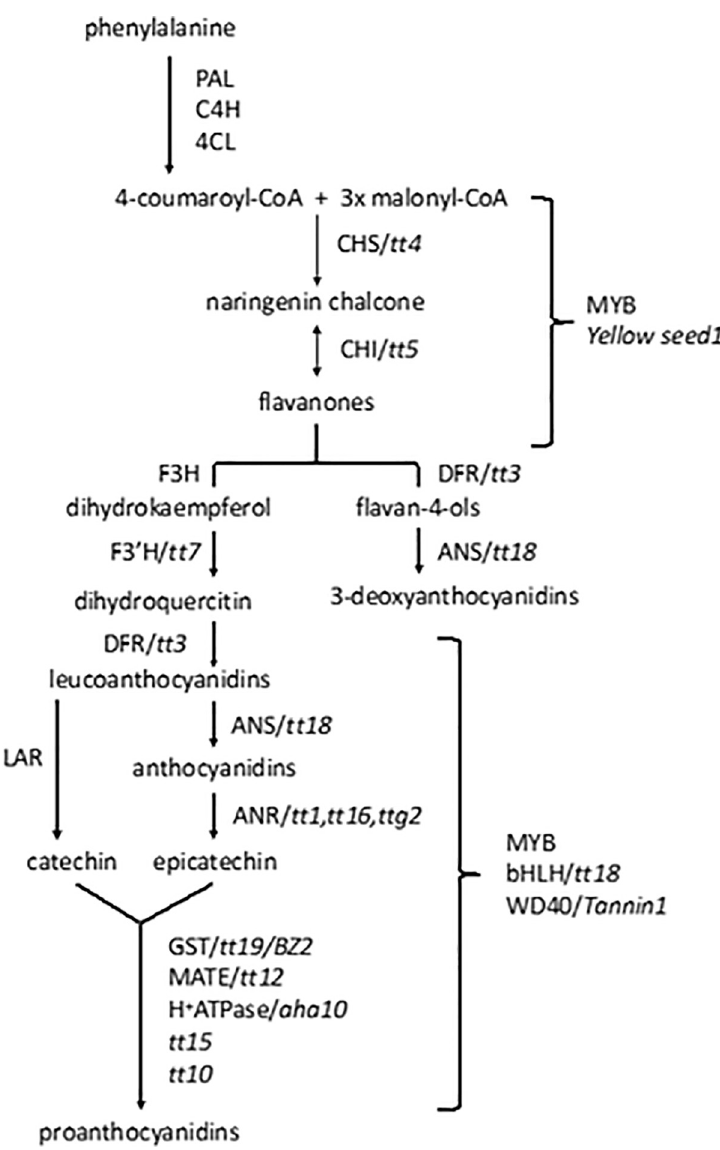
Fig 1. Biosynthesis and regulation of flavonoids. PAL = phenylalanine ammonia lypase, C4H = trans-cinnamate 4-monoxygenase, 4CL = 4-coumarate CoA ligase; CHS = chalcone synthase; CHI = chalcone isomerase; F3H = chalcone-flavanone isomerase hydroxylase; F3’H = flavanone 3’-hydroxylase; DFR = dihydroflavonol- 4-reductase; ANS = anthocyanidin synthase; ANR = anthocyanidin reductase; GST = glutathione-S-transferase; MATE = multidrug and toxic efflux transporter; LAR = leucoanthocyanidin reductase; TT = transparent testa; TTG = transparent testa